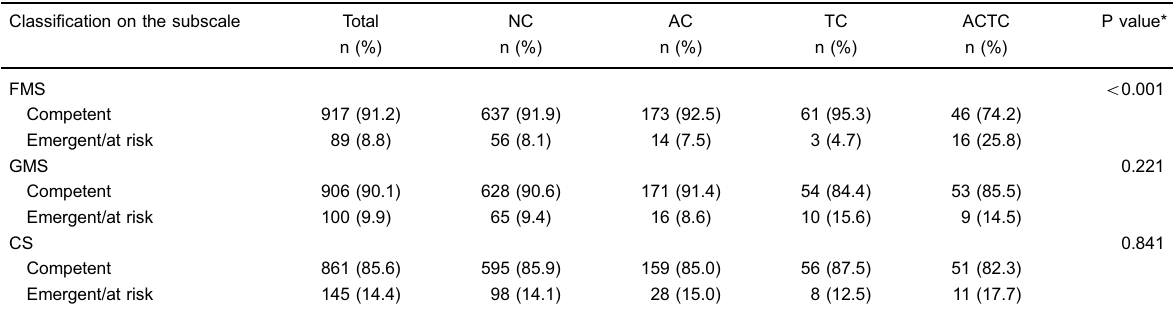
Table 3. Absolute and relative frequency of participants in the groups of alcohol and tobacco consumption and classi fi cation on the developmental subscales in Ribeirão Preto, SP, Brazil, 2010/13. Classi fi cation on the